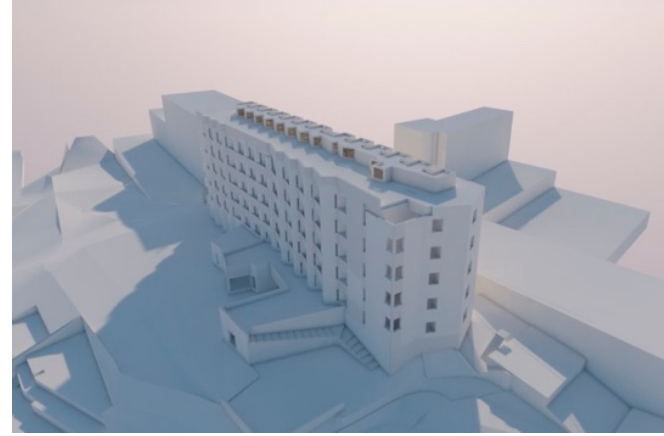
Figure 9. Porto. Model.